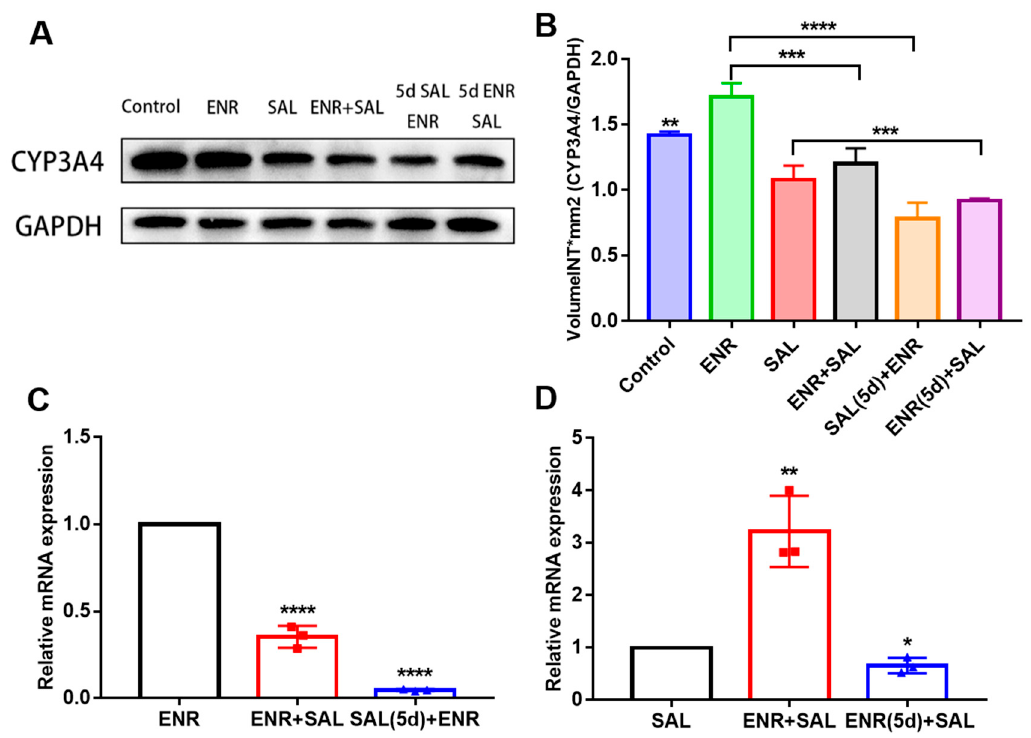
Figure 4. Effects of ENR and SAL on CYP3A4 gene expression levels in liver. ( A ) is the immunoblotting image and ( B ) is the gray value of the immunoblot band; ( C ) is the effects of single ENR as control group, single combined administration group (ENR + SAL) and continuous 5d SAL group (SAL (5d) + ENR) on the mRNA expression level of CYP3A4. ( D ) is the effects of single SAL as control group, single combined administration group (ENR + SAL) and continuous 5d ENR group (ENR (5d) + SAL) on the mRNA expression level of CYP3A4. ** on the control group indicates a significant difference between the other groups and the control group, p < 0.01 ( B ). * means p < 0.05; ** means p < 0.01; *** means p < 0.005; **** means p < 0.001.